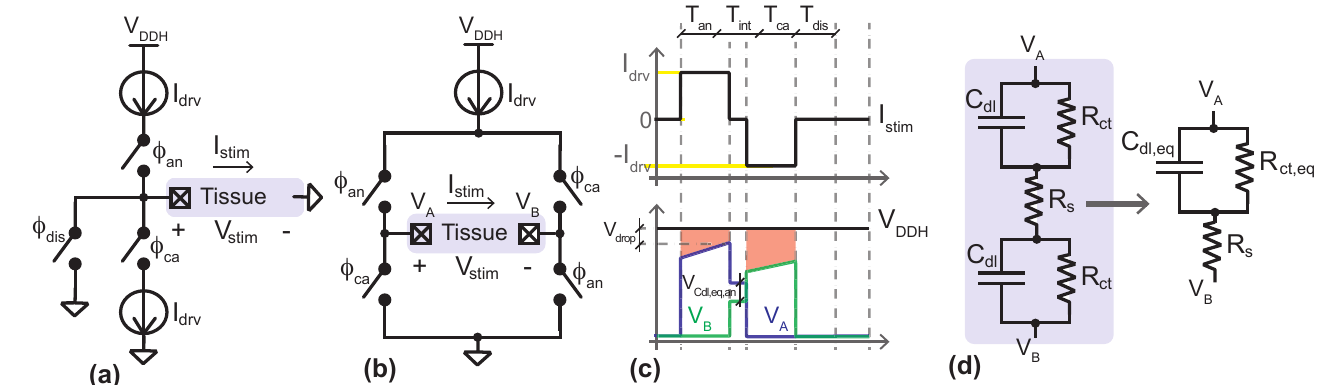
Figure 2. ( a , b ) Simplified schematics of unipolar and bipolar electrical neural stimulators. ( c ) Current and voltage stimulation waveforms. ( d ) Electrical model of the ETI and lumped